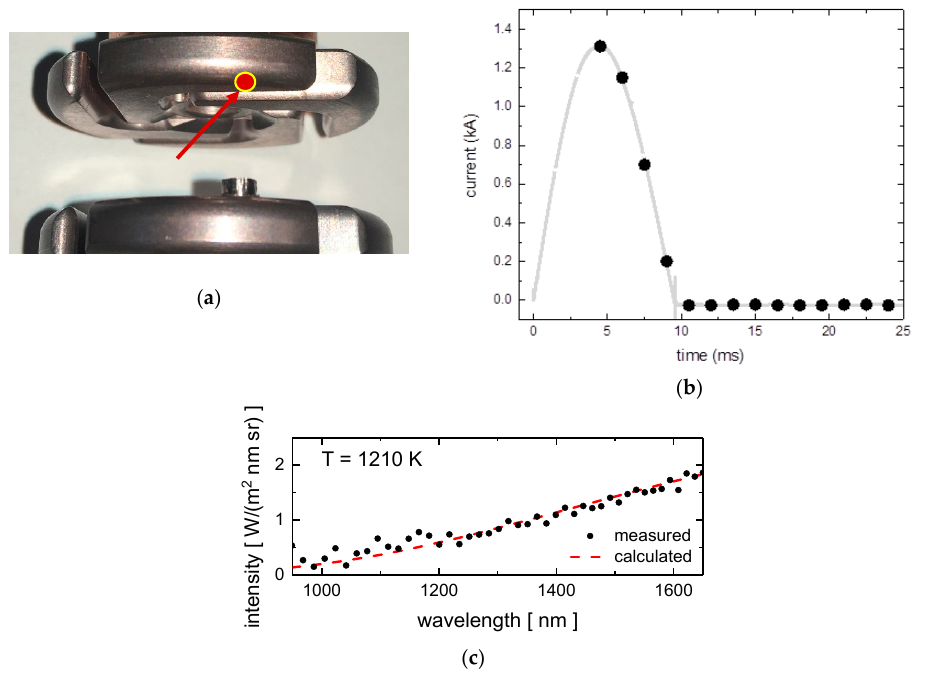
Figure 4. ( a ) Measurement position in case of NIR spectroscopy (red circle). Anode on the top, cathode in the bottom. ( b ) Acquisition instants of NIR spectroscopy related to the current shape. ( c ) Sample of NIR spectrum suitable for temperature evaluation: instant of time 1.25 ms after current interruption.